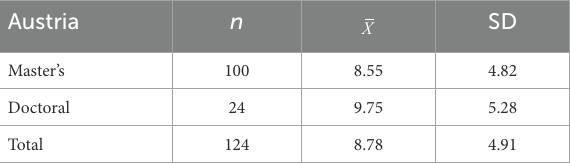
TABLE 2 Descriptive statistics for master’s and doctoral theses in Austria.